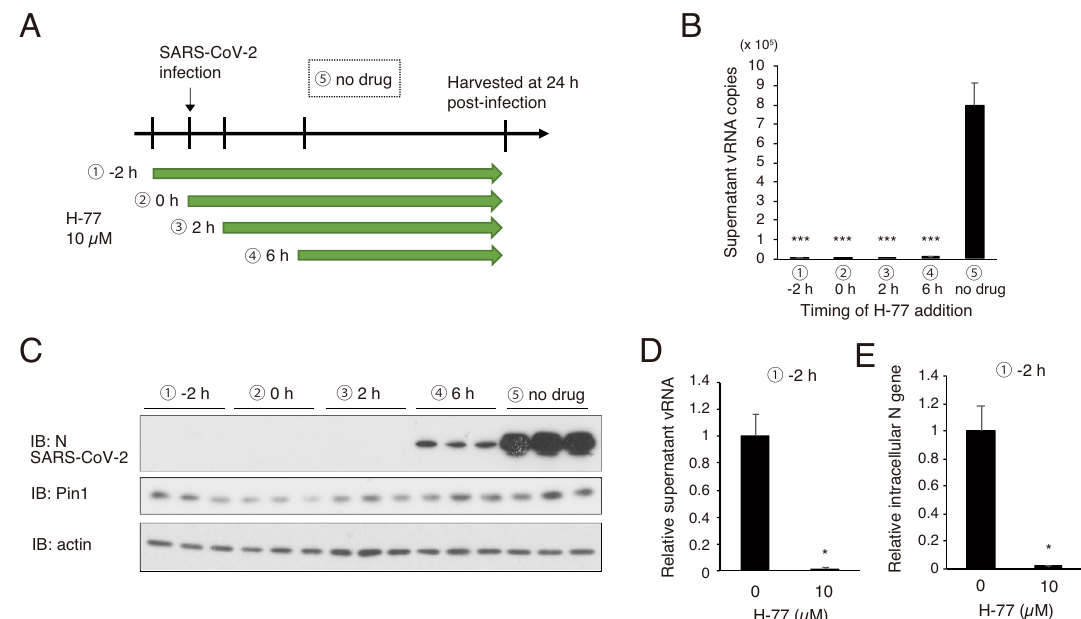
Figure 3. Effect of H-77 treatment timing on growth inhibition of SARS-CoV-2. VeroE6/TMPRSS2 cells were infected with SARS-CoV-2 (MOI of 0.01), and H-77 (final concentration 10 µM) was added at different times as indicated. Cells and supernatants were harvested 24 h after infection. ( A ) Schematic diagram showing the timing of drug addition and experimental conditions. ① 2 h before viral infection, ② simultaneously with a viral infection, ③ 2 h after infection, ④ 6 h after infection, and ⑤ without drug addition. ( B ) Copy number per PCR reaction (8 µl) of vRNA in the culture supernatant 24 h after infection (n = 3). Error bars indicate standard deviation. *** P < 0.001, Mann–Whitney U test, compared with ⑤ no drug. ( C ) Western blotting of cell lysates with SARS-CoV-2 N, Pin1, and actin antibodies (Triplicate in the figure). Full-length blots are shown in Supplementary Fig. 4. ( D , E ) VeroE6/TMPRSS2 cells were pretreated with 10 µM H-77 under the condition described in ① (starting from 2 h before infection), and RNA was extracted from the cells 24 h after viral infection. RT-qPCR was used to measure vRNA in the supernatant collected at the same time (n = 3) ( D ) and intracellular N genes (mainly mRNA, adjusted for total RNA content) (n = 3) ( E ). Error bars represent standard deviation. * P < 0.05, Mann–Whitney U